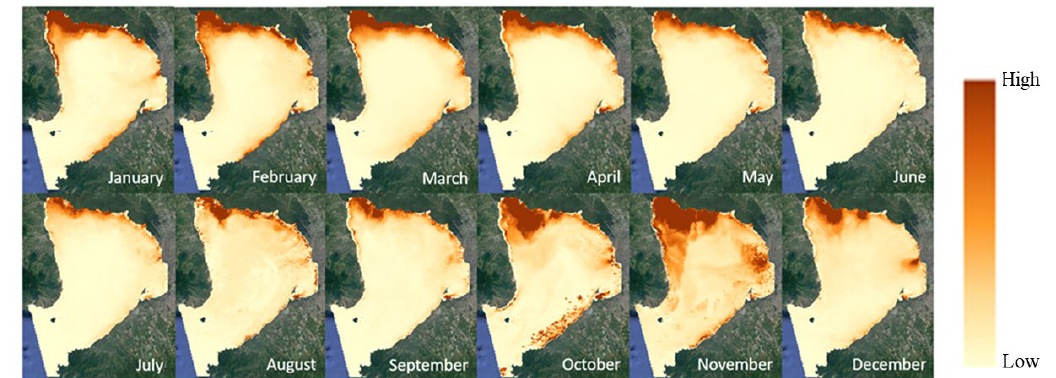
Figure 5. TSM distribution in Manila Bay for 2020. Darker orange areas indicate higher concentration. High values are found in the nearshore areas especially in the northern part of the bay.